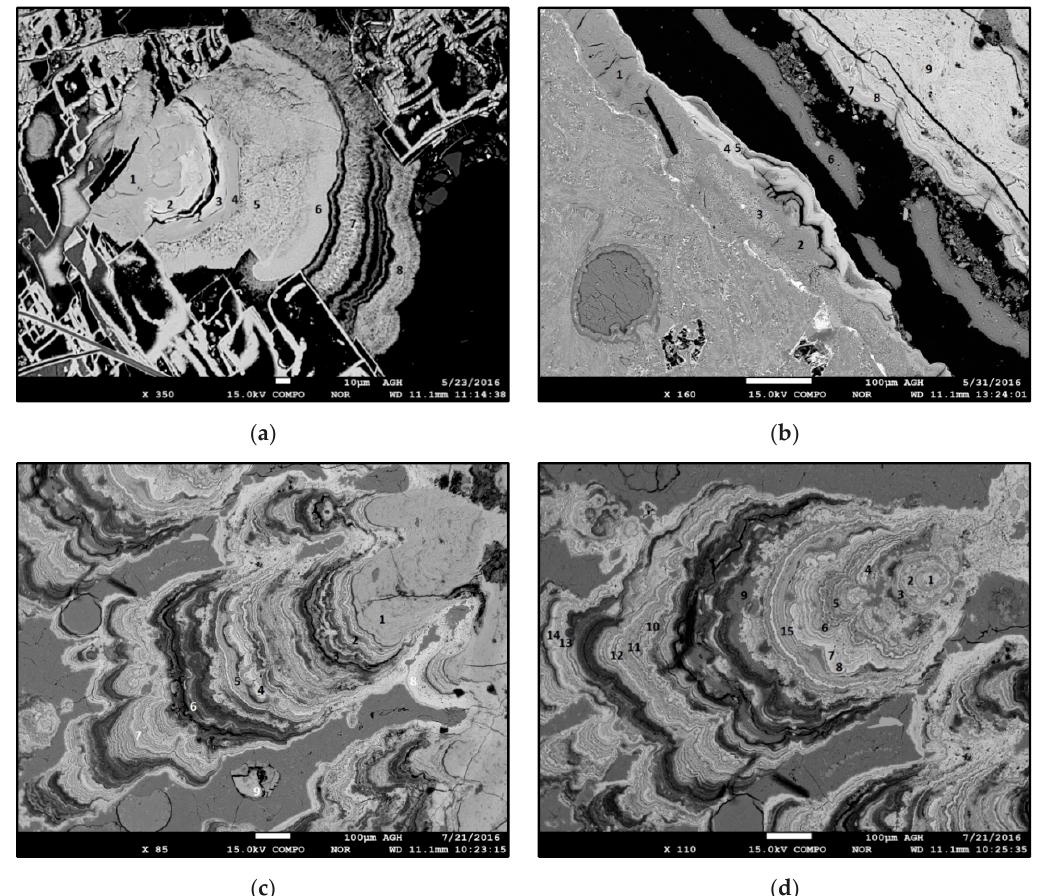
Figure 7. Representative EPMA images of DHR Fe-Mn crusts minerals: ( a ) (1, 3, 4) sequence of asbolane with high grade of Ni (6.2–7.3%); (2) Ni-Co asbolane showing >1.6% Co; uniform texture with change in (5) to more patchy and porous; (5) low-grade Ni-asbolane with higher Mn content 47% and low alkali content; (6) low-grade Ni-(Co) asbolane; (7) and (8) Ni-asbolane (or buserite) with fibreous texture and Ni content from 4.1 to 5.8; ( b ) basalt-crust transition zone with elongated coatings of phosphatized clay minerals (1, 2) (glauconite, nontronite, traces of ferroaluminoceladonite) with intergrowths of hydroxyfluoroapatite (3); “vein” in central part with remnant filling of nontronite, glauconite and celadonite; (4, 5) Fe-rich colomorphs of Ti-rich feroxyhyte-ferrihydrite; (7, 8) lamellae (up to 5 µ m) of vernadite; (9) massive vernadite with wavy and grainy texture and increased Ti content; ( c ) thick vernadite (1) with higher content of Co (>0.6%) and Ti (>1%); (2) Ni-Cu asbolane (~10 µ m) with Ni (>3.5%), Cu (>1%), Zn (>0.5%) increased Mg content and depleted with P, Co and Ti; (3) Fe-chlorites depleted with metals; traces of alteration; (4) small lamellae of asbolane (~ µ m) with Ni + Cu + (Zn) content >4%; (5) mixed group of vernadite and asbolane, slightly depleted with metals; (6) asbolane with Ni + Cu + (Zn) content >5% and increased Mg content; (7) bright laminae of Mn-rich asbolane slightly depleted with metals and Mg; (8) asbolane depleted with metals (~2%); (9) crushed grain of non-identified Fe-Si-Ti rich mineral; ( d ) small aggregate-core (1) of Ni-(Cu) asbolane with amount of Ni + Cu + Zn (~4%) and increased Mg content; asbolane (2, 3) showing metal depletion down to 2.5%; asbolane (4) with high content of Ni + Cu + Zn (4.5%) and Mg, depleted with alkali metals; sequence of asbolane laminae (5–8) showing increase of ∑ (Ni, Cu, Zn) content (>5%); zeolite (heulandite-clinoptilolite) layer (9) depleted with metals, Sr, Ba and Ca; being part of crushed-like alteration zone; Ni-Cu asbolane sequence (10–12) showing increase of metals content up to 5.2%; another sequence of Ni-Cu asbolane (13, 14) showing increased metal content; (15) mixed laminae of vernadite and asbolane; higher content of Ti + Co (~1.7%) in